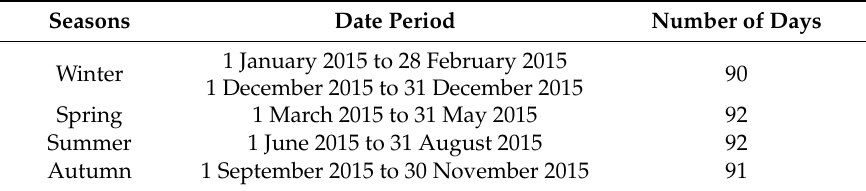
Therefore, the winter season has the fewest number of days.